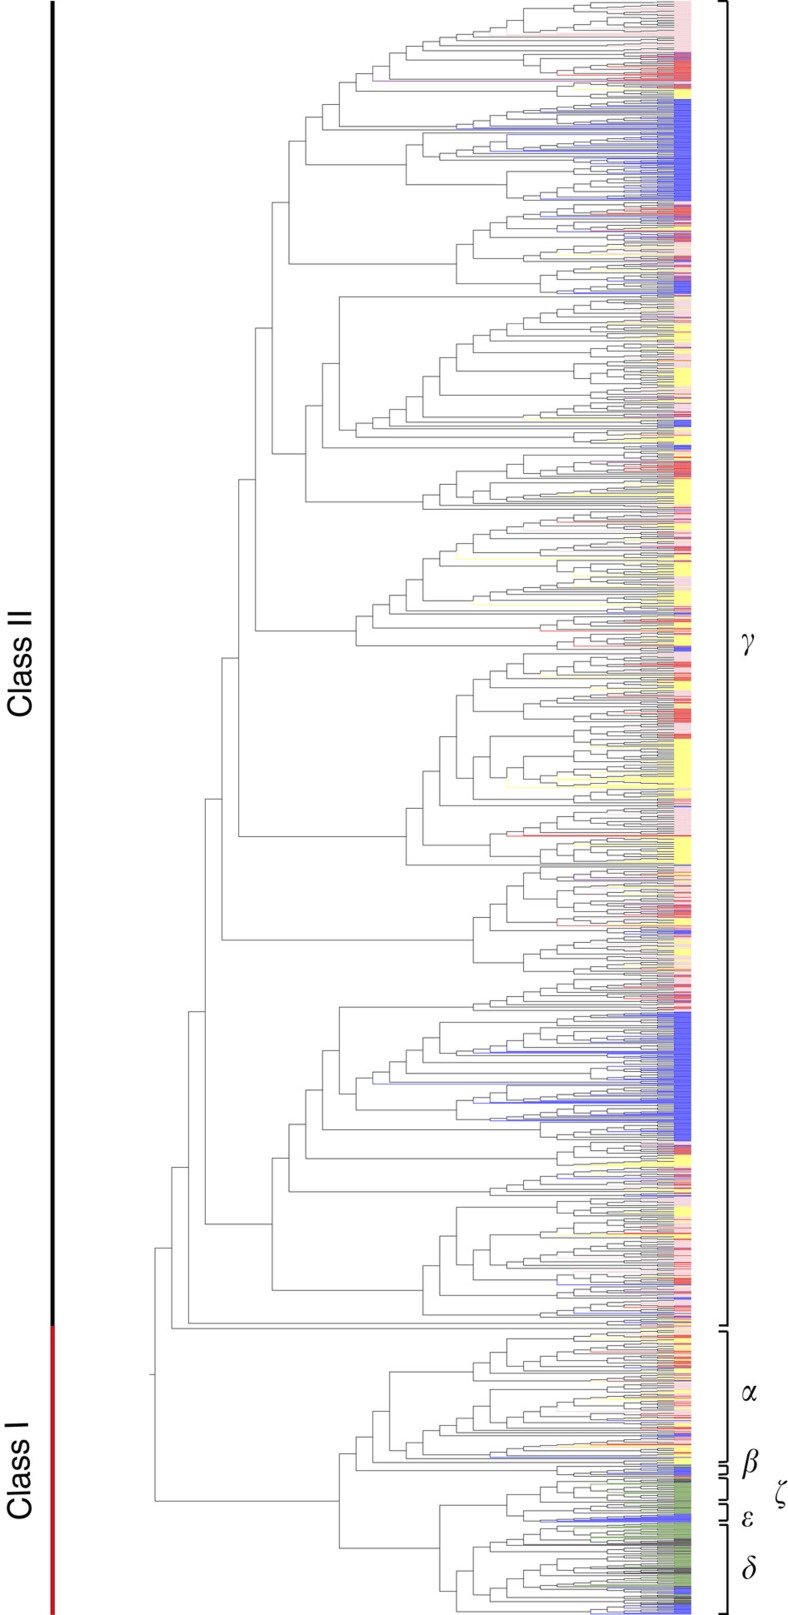
Phylogenetic tree of functional OR genes in seven species.The Class I genes (including α, β, ɛ, ζ and δ ORs) encode proteins used for scent detection in water. The Class II gene (γ-OR) encode proteins used for scent detectionin air. G. japonicus has undergone extensive expansion in Class II genes. Red, G. japonicus; blue, X. tropicalis; green, D. rerio; purple, An. carolinensis; yellow, H. sapiens; pink, Al. sinensis; black, T. rubripes.